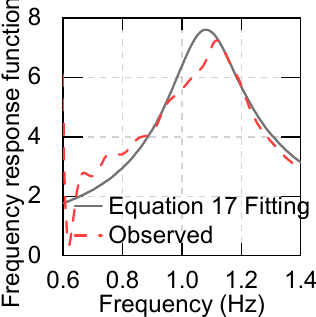
Figure 19. Modified modal analysis using Equation (16).